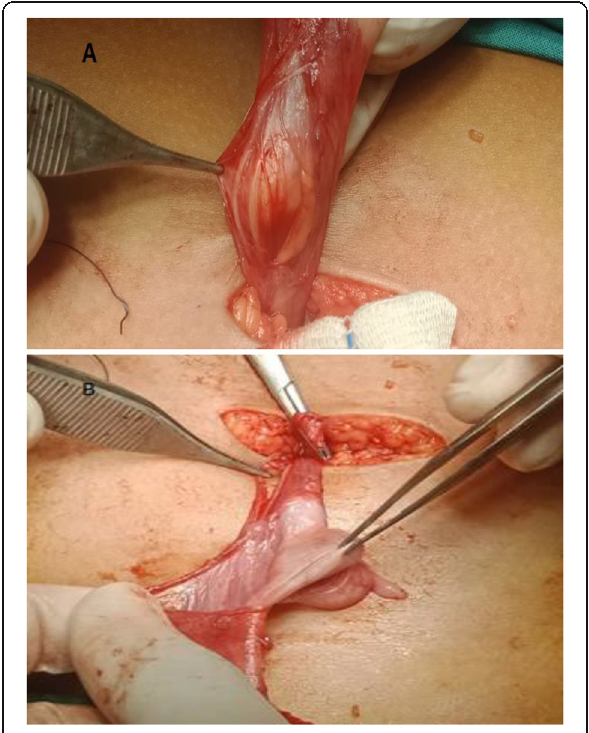
Fig. 6 a Duplication of the vas deferens. b Left epididymis completely separated from the left testis (the upper non-toothed forceps lies between the double vasa deferentia)